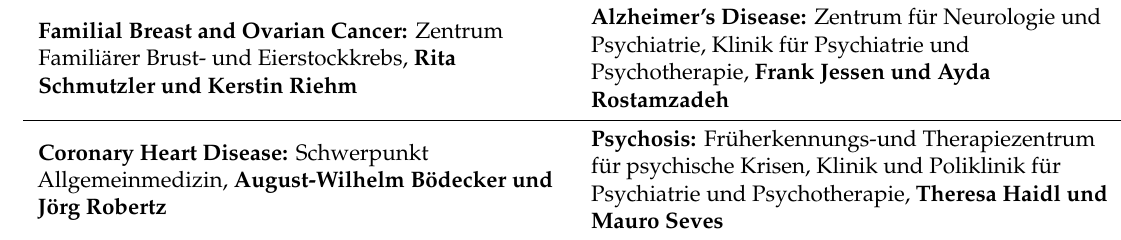
Table A1. Institutions involved in the recruitment